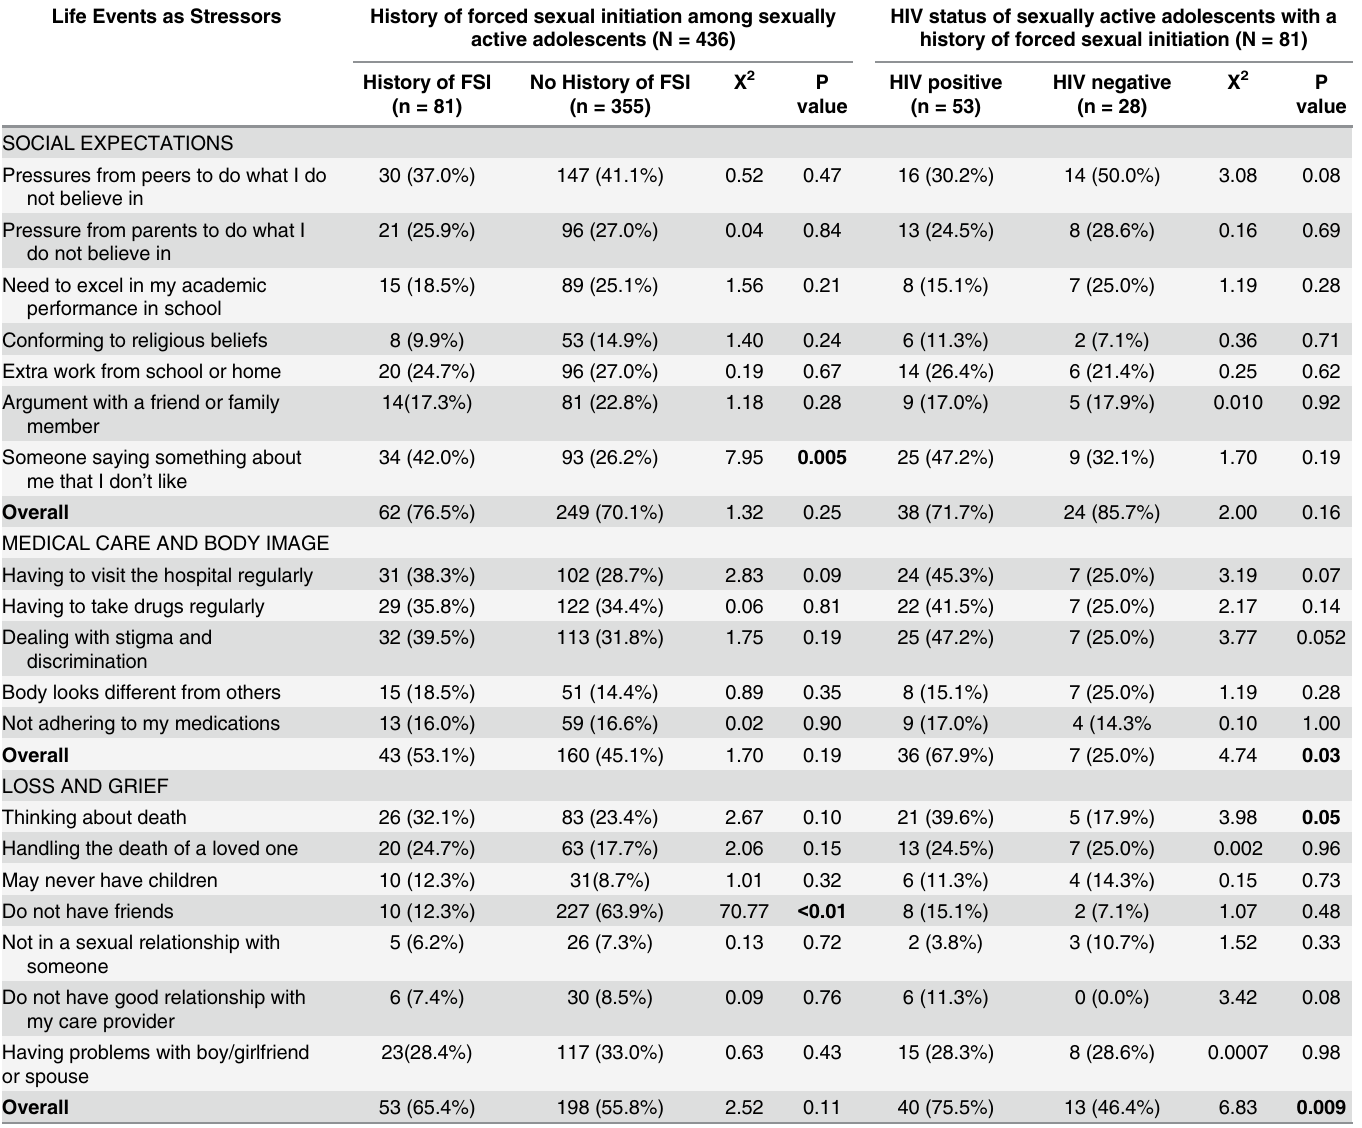
Table 3. Experience of life stressors, forced sexual initiation, and self-reported HIV status. Life Events as